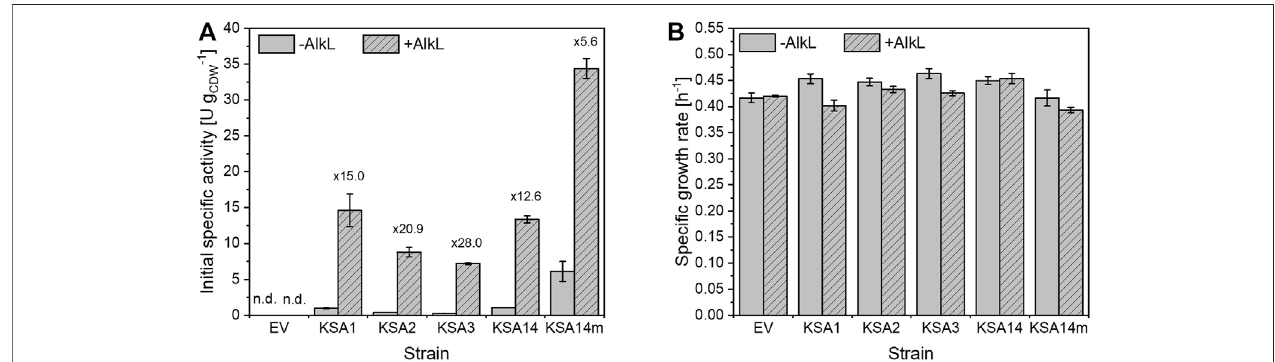
FIGURE 5 | Initial speci fi c testosterone hydroxylation activities (A) of resting E. coli BL21-Gold(DE3) cells carrying pETM11 with genes encoding different BM3 variants together with or without alkL after 5 h of induction in M9 medium supplemented with 0.5% (w/v) glucose. Resting cell preparation and activity assays were performed as described in the Materials and Methods section. (B) Speci fi c growth rates of the respective strains in M9 medium upon induction with 0.1 mM IPTG and addition of 0.5 mM 5-aminolevulinic acid. Average values and standard deviations of two biological replicates are